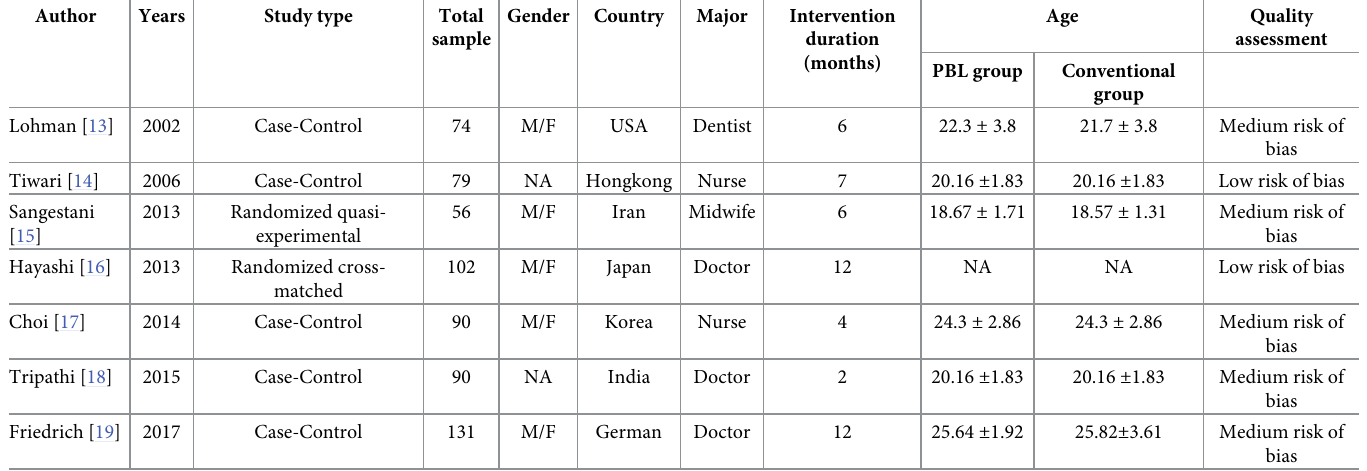
Fig 1. PRISMA diagram of study selection result. From : Moher D, Liberati A, Tetzlaff J, Altman DG, The PRISMA Group (2009). P referred R eporting I tems for S ystematic Reviews and M eta- A nalyses: The PRISMA Statement PLoS Med 6(7): e1000097. doi: 10.1371/journal.pmed1000097 For more information, visit www.prisma-statement.org. https://doi.org/10.1371/journal.pone.0277339.g001 Table 1. Baseline characteristics and quality assessment in each